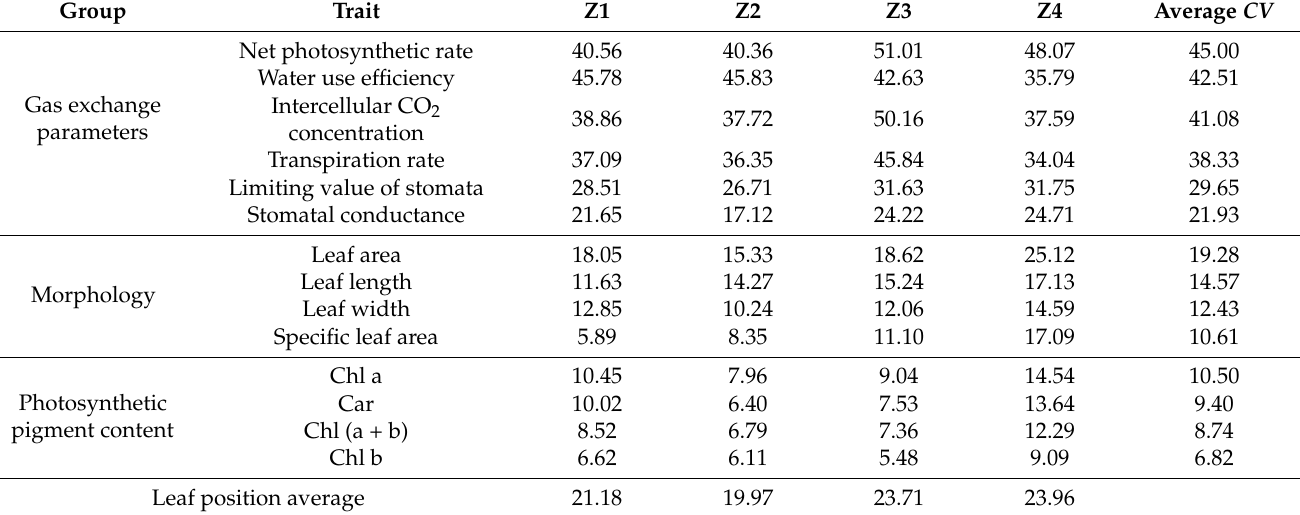
Table 2. Coefficient of variation ( CV %) for each trait and leaf position, ranked from highest to lowest across leaf position ( n =